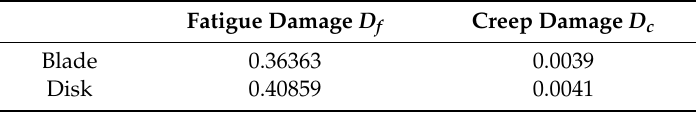
Figure 8. Distribution of disk creep strain.